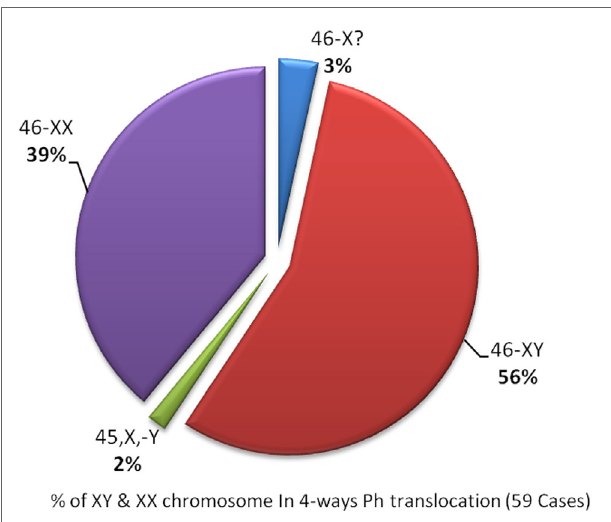
FIGURe 3 | percentage of four-way complex variant translocation in male and female CML patients